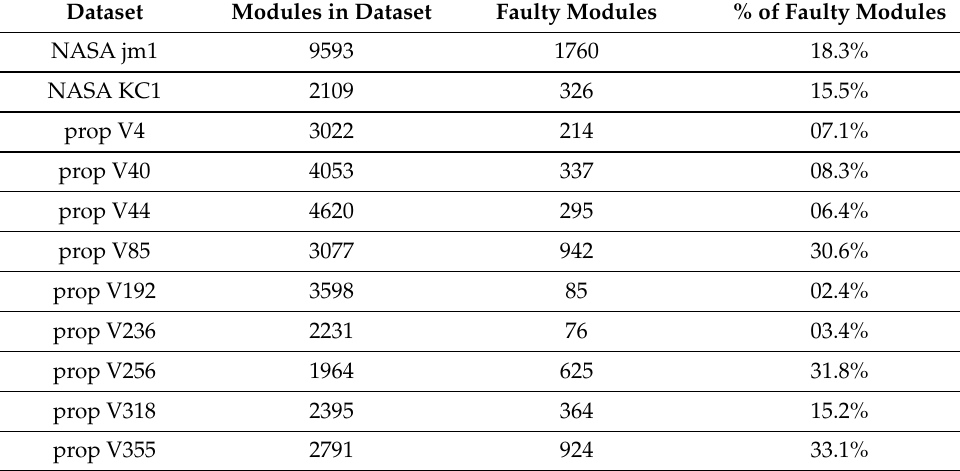
Table 4. Summary of